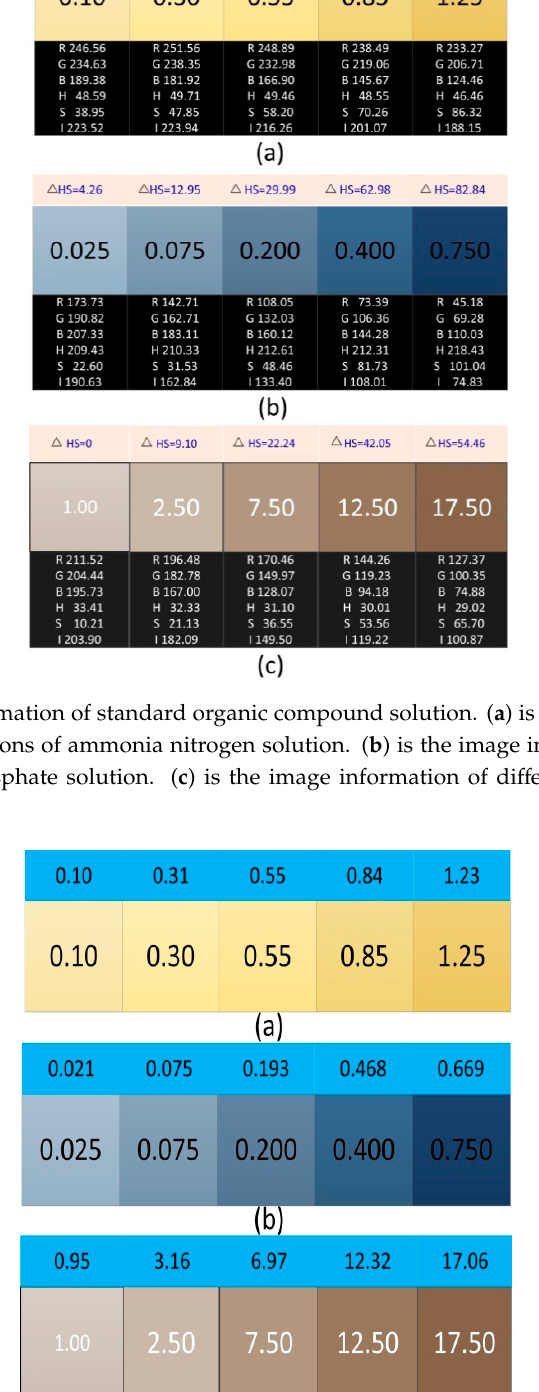
Figure 15. Measurement results of standard solution for ammonia nitrogen, phosphate, and chloride. ( a ) is the measurement results of standard solution for ammonia nitrogen. ( b ) is the measurement